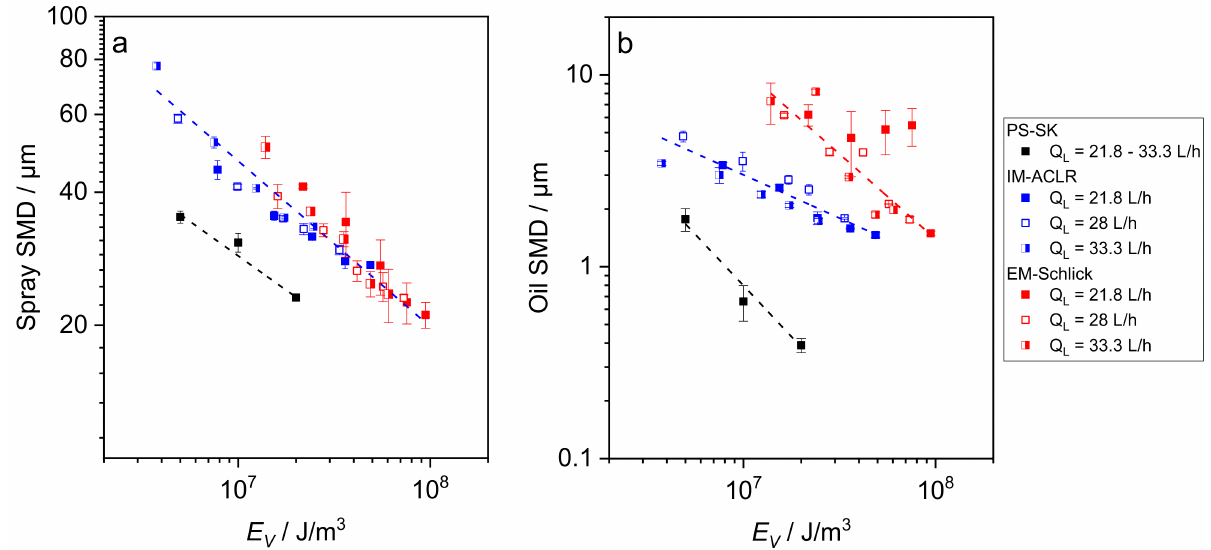
Figure 4. Sauter mean diameter of ( a ) spray droplets and ( b ) oil droplets against energy density for the investigated nozzles at different volume flow rates Q L . PS-SK: Pressure swirl nozzle; IM-ACLR: Internal mixing twin-fluid nozzle; EM-Schlick: External mixing twin-fluid nozzle. Data was fitted using Equation (1). Table 2. Constants C and b as well as coefficients of determination for spray and oil droplets for the fit from Equation (1). PS-SK: Pressure swirl nozzle; IM-ACLR: Internal mixing twin-fluid nozzle; EM-Schlick: External mixing twin-fluid nozzle. Nozzle